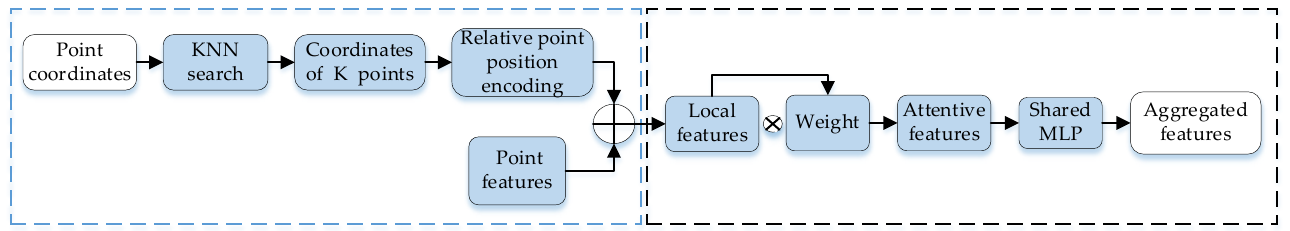
Figure 4. Atrous convolution with different dilation rates. ( a ) r